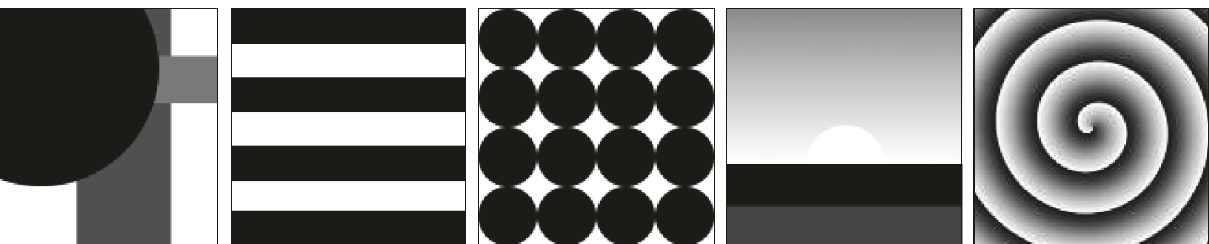
Figure 3: Compositional target set.